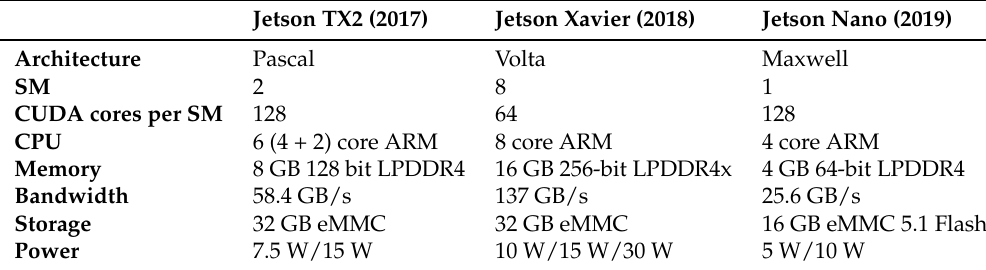
Table 1. List of specifications for the embedded devices used in this